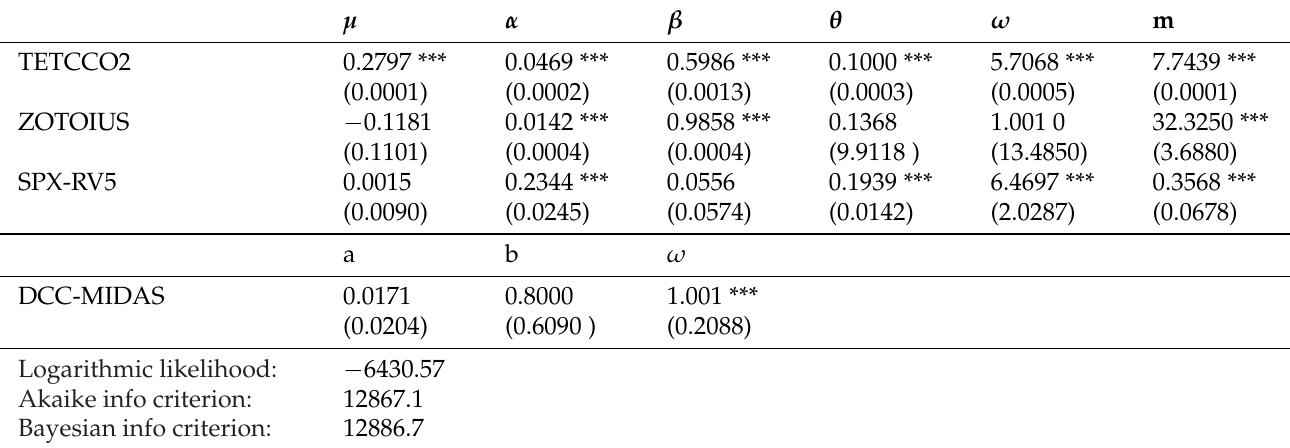
Table 3. Dynamic Conditional Correlation with Mixed Data Sampling (DCC-MIDAS) estimates for the baseline specification including Total Fossil Fuels CO 2 emissions, Total Industrial Production Index, and S&P 500